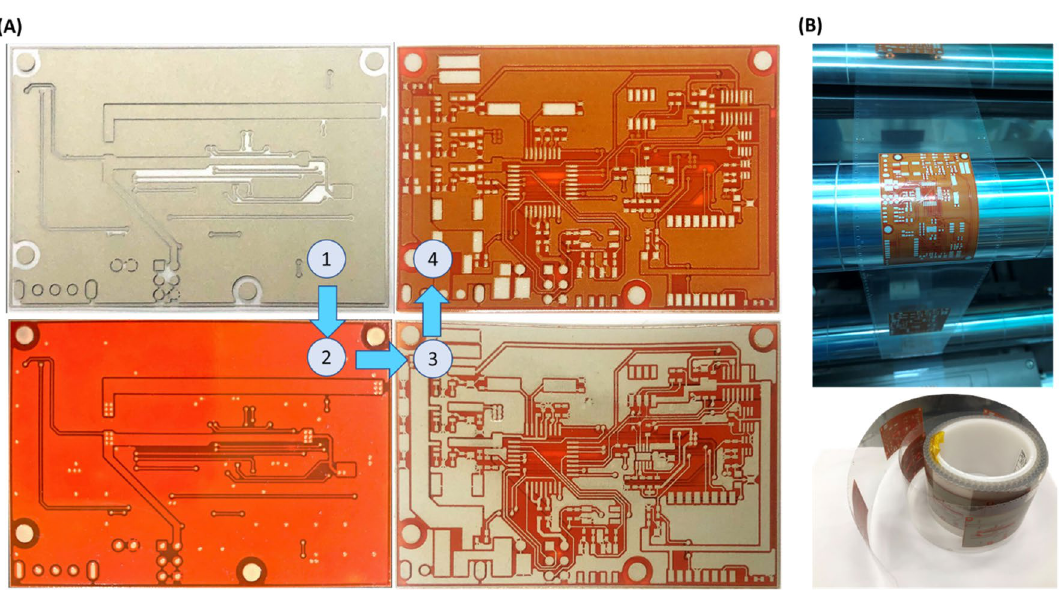
Figure 7. IoT circuit platform printing using roll-to-roll screen printing. ( A ) 4-layer printing of IoT circuit platform, and ( B ) the printed product on the web and final printed circuit